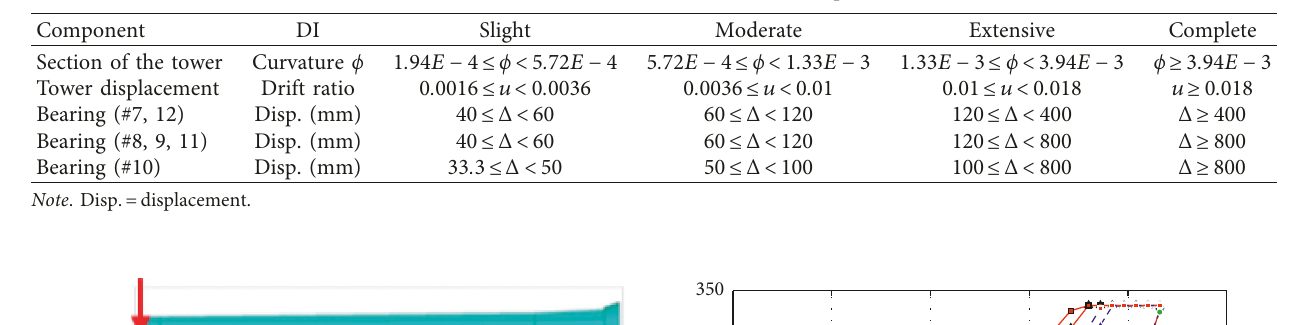
Table 3: Quantified limit states of various components.